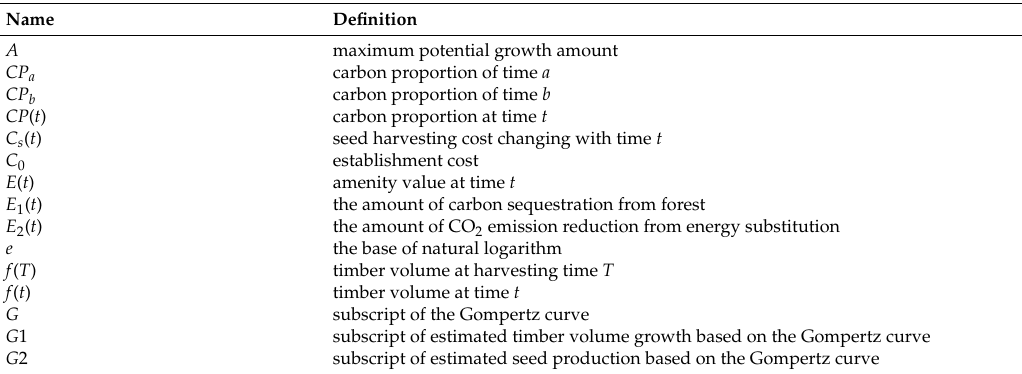
Table A2. Definition of variables and